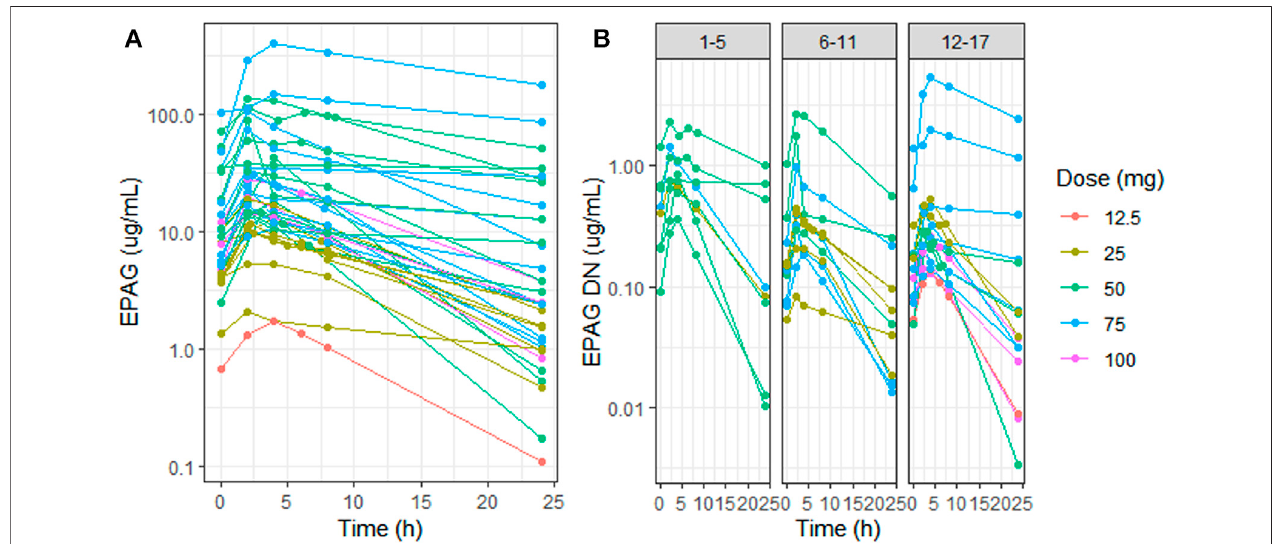
FIGURE 1 | Eltrombopag concentration (log scale) vs. time in all patients (A) and dose-normalized eltrombopag concentration (log scale) vs. time in the three different age groups (1 – 5 y, 6 – 11 y, and 12 – 17 y) (B) . Patient pro fi les were strati fi ed by dose: 12.5 mg (red), 25 mg (light-green), 50 mg (green), 75 mg (blue), and 100 mg (purple). EPAG: eltrombopag and DN: